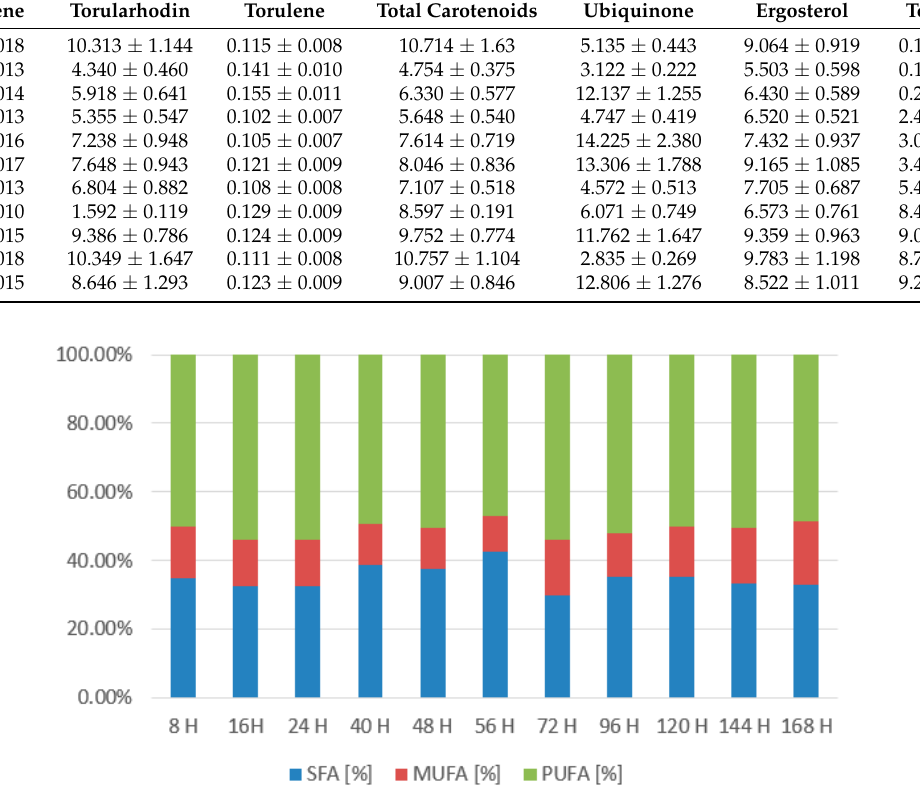
Figure 11. Fatty acid production of Rhodotorula kratochvilovae in a bioreactor cultivation on coffee oil and glycerol with lipase induction.